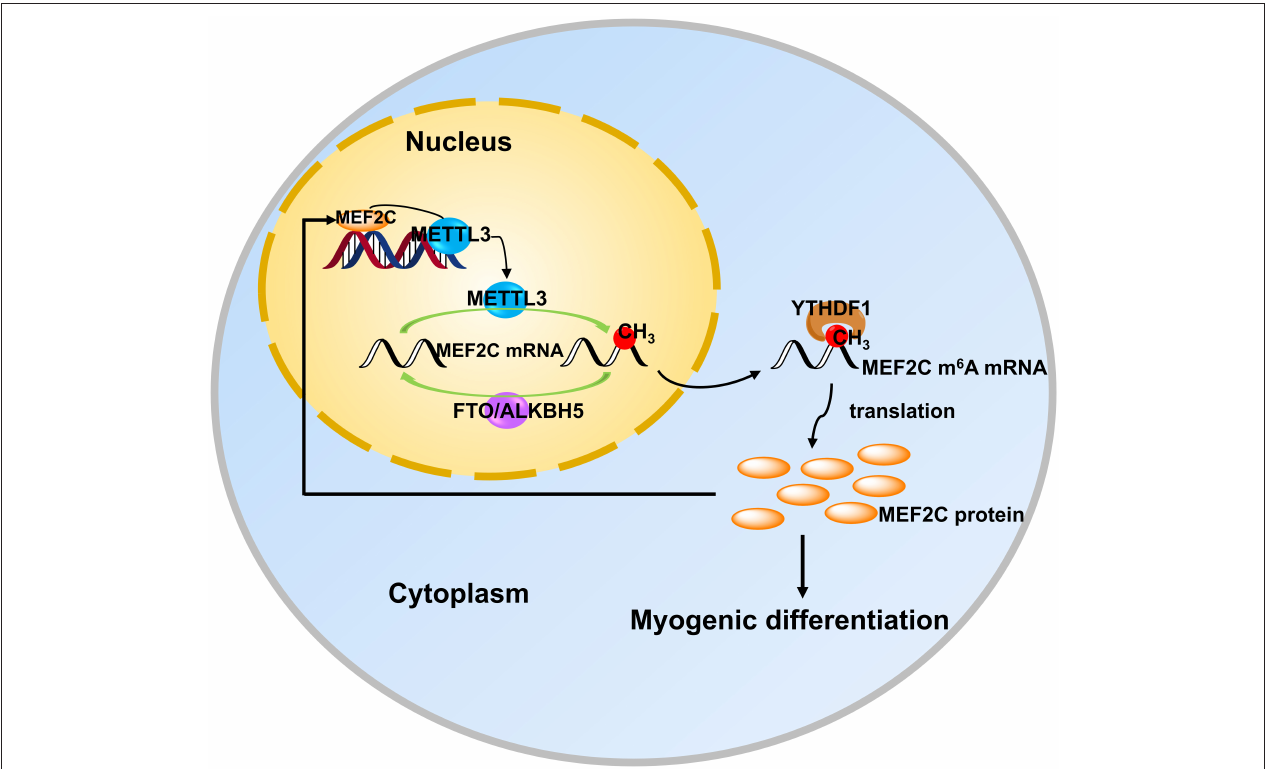
FIGURE 7 | MEF2C promotes the differentiation of bovine myoblasts by posttranscriptional activation of the METTL3-m 6 A-YTHDF1 axis. METTL3 catalyzes the N 6 -methylation of MEF2C mRNA, and YTHDF1 recognizes this modification site to promote the translation of MEF2C. Then, MEF2C can directly bind to the promoter region of METTL3 to activate its expression, suggesting that there is a positive feedback loop underlying the process of bovine skeletal myoblast